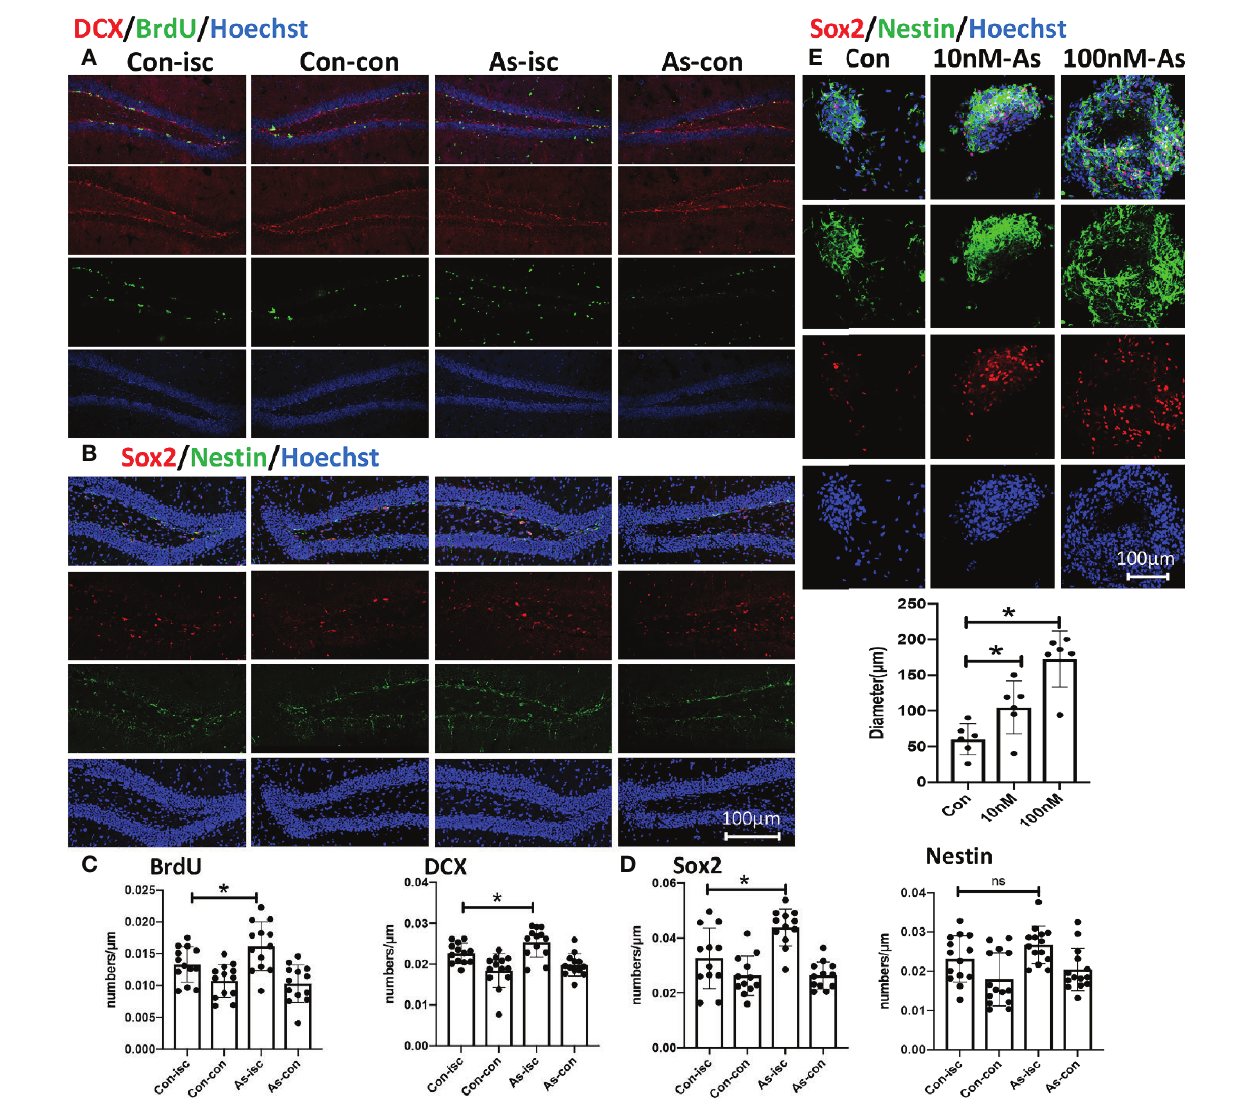
FIGURE 2 | As IV promotes neurogenesis in the hippocampal DG after stroke in vivo and activates NSCs in vitro . (A, B) Double-immunostaining for DCX/BrdU and Sox2/Nestin in the hippocampal DG, respectively. (C, D) Notice signi fi cantly increased numbers of DCX-, BrdU-, and Sox2- positive cells in the As group. n = 5. *p < 0.05. (E) Double-immunostaining for Sox2/Nestin for NSCs. Notably enlarged diameters of NSCs were in the 10 and 100 nM As groups. *p < 0.05. DCX, doublecortin; As, Astragalosidec; Con, control; Con-isc, the ischemic hippocampus in the control group; Con-con, the contralateral hippocampus in the control group; As-isc, the ischemic hippocampus in the As group; As-con, the contralateral hippocampus in the As group; NSCs, neural stem cells; DG, dentate